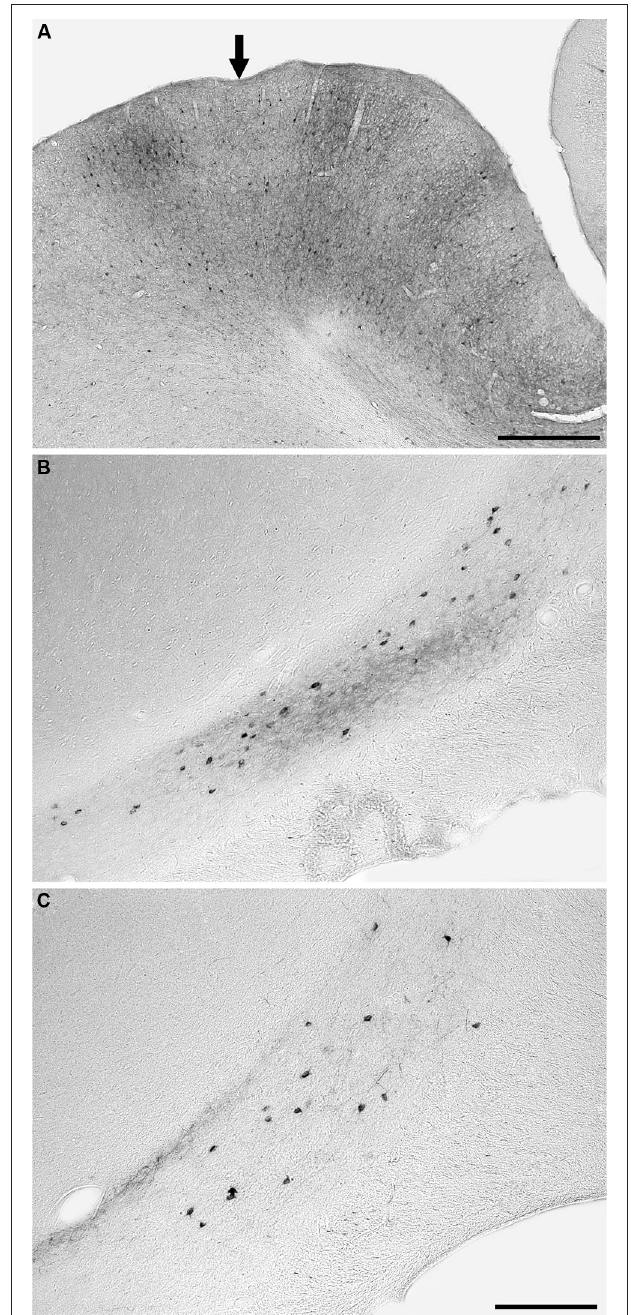
FIGURE 4 | Photomicrographs of an example injection site in area 21 (A) and labeled cells and terminals in the claustrum following injections into area 18 (B) and area 21 (C) . Note that the injected tracer has been mostly taken up from the injection site (entry of microsyringe into cortex marked with an arrow ) and that the injection sites did not encompass any of the underlying white matter. Following injections in both areas 18 and 21, retrogradely labeled neurons and anterogradely labeled terminals were observed, but in the depicted cases the anterograde labeling was far stronger after injection into area 18. In all images medial is to the right and dorsal to the top. The scale bar in A = 500 µ m, the scale bar in C = 250 µ m and applies to B and C